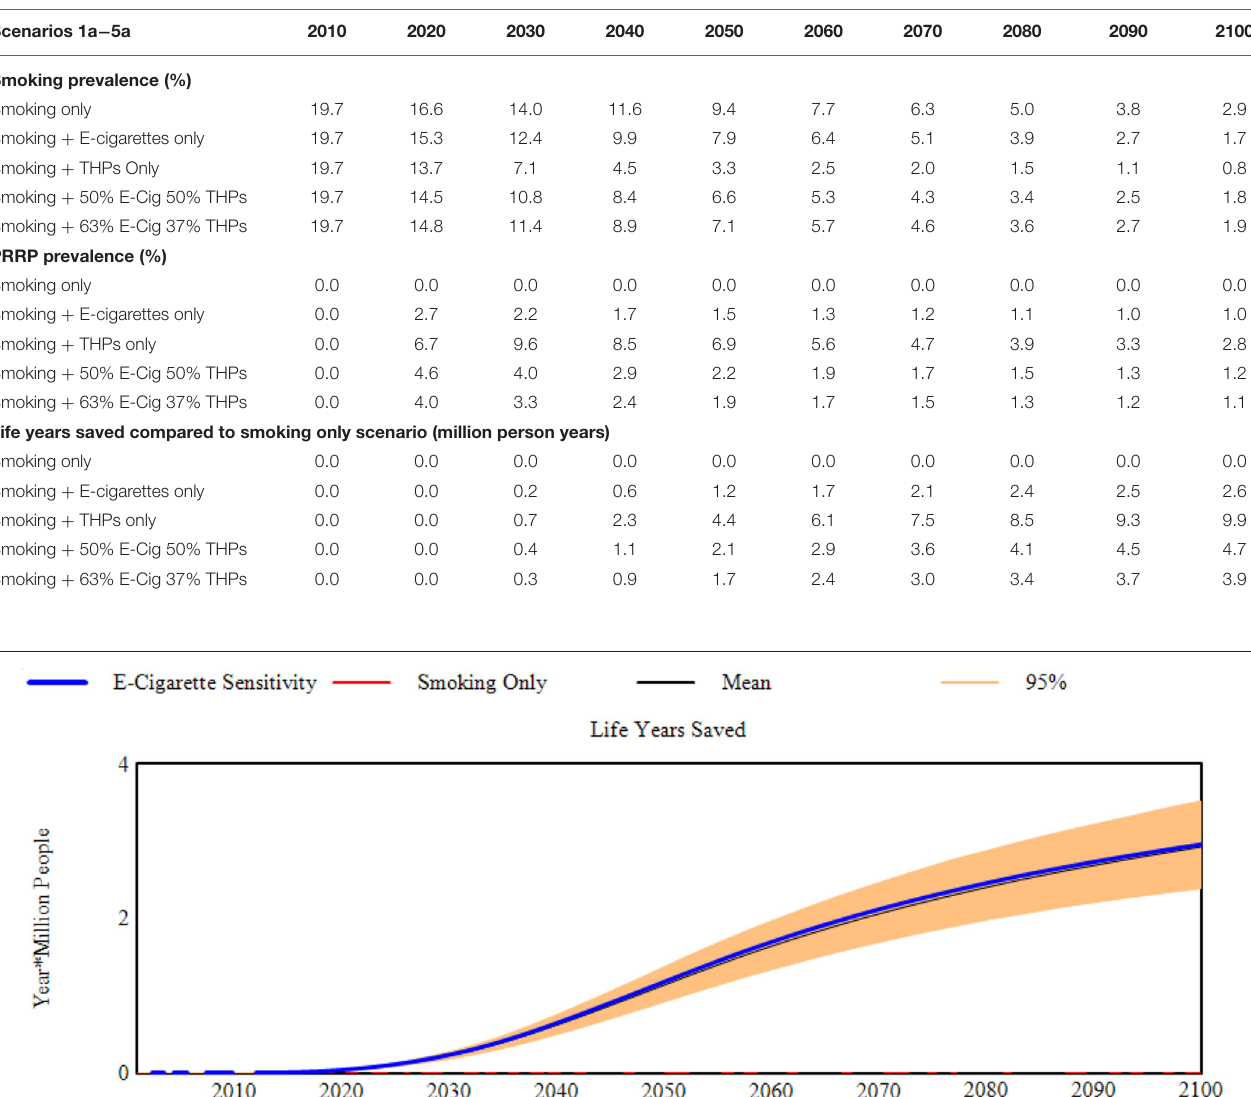
TABLE 5 | Projected prevalence and reduction of life years lost for scenarios 1a − 5a. Scenarios 1a − 5a